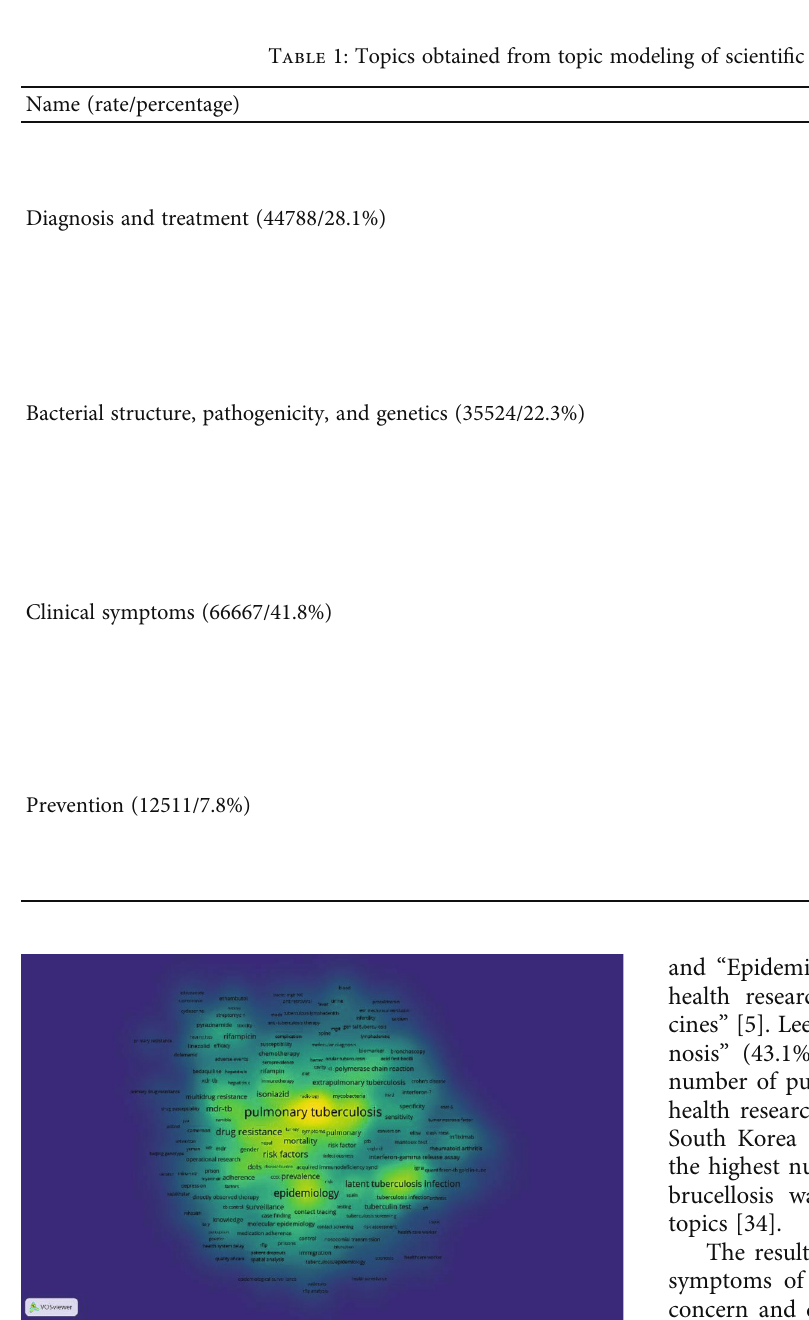
Figure 2: Densities of keywords in the topic “ Diagnosis and treatment ” in scienti fi c articles on